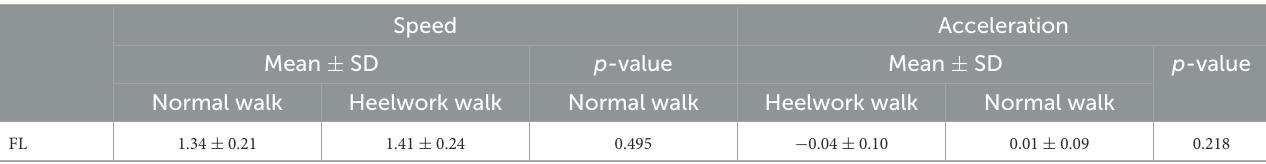
TABLE 1 Mean values, standard deviation, and p -values of the speed and acceleration based on the left forelimb between normal walking and heelwork walking.